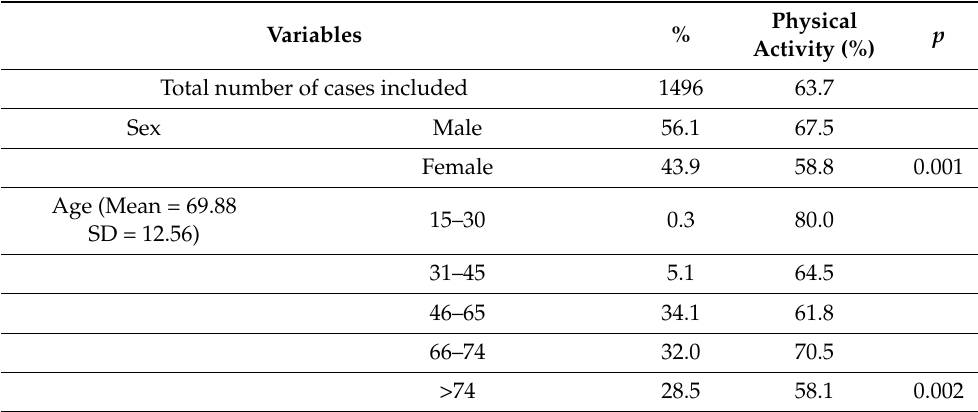
Table 1. Socio-demographic and clinical characteristics of the sample